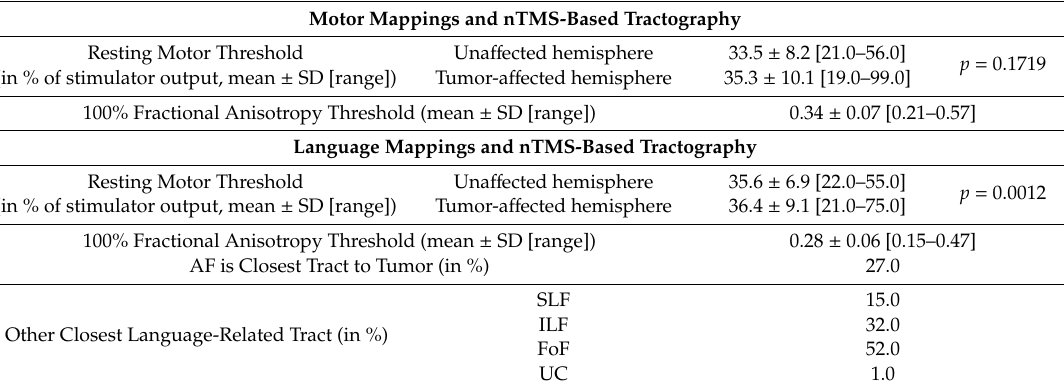
Table 2. Mapping and tractography